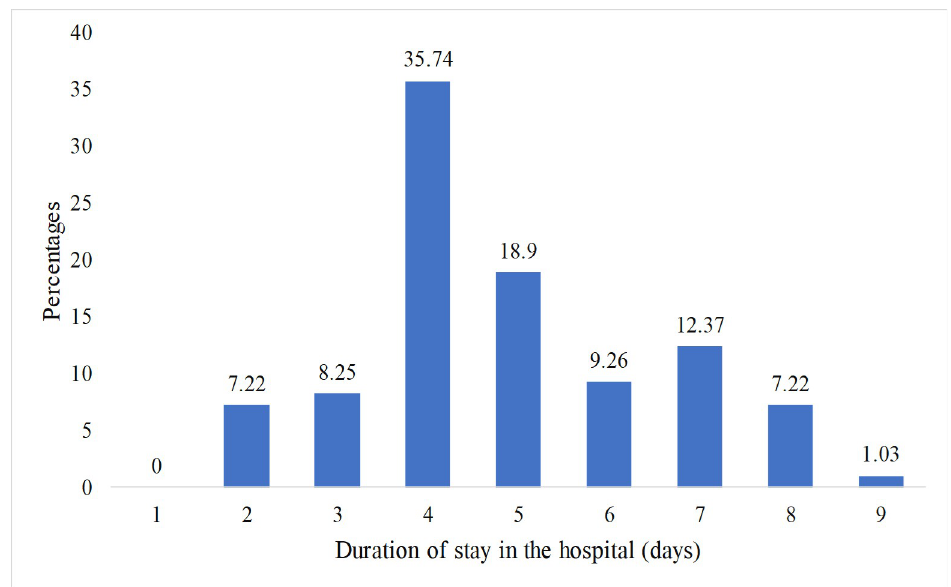
Fig 6. Distribution of the patients exhibiting varying recovery time after hospitalization.